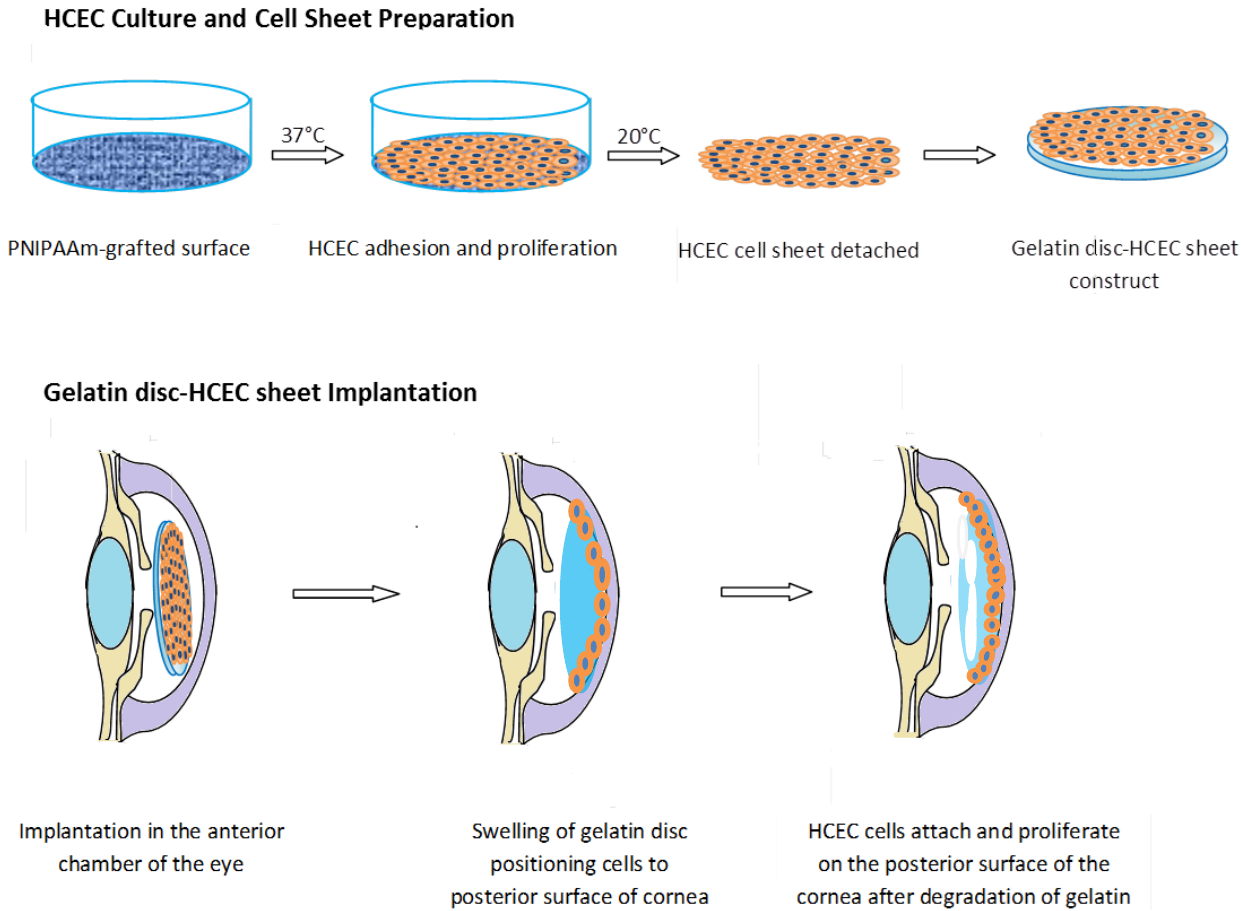
Figure 3. Schematic diagram of HCEC-gelatin sheet implantation reported by Lai et al. [73]. Primary endothelial cells were cultured upon a pNIPAM culture surface until confluent. The cell sheet was detached and transferred to a gelatin disc. The gelatin disc was implanted into the anterior chamber of the rabbit eye in which the endothelium had been removed surgically. The gelatin disc swelled localizing the corneal endothelial cells against the posterior surface of the cornea, where the cells proliferated and restored the cornea to health. Figure adapted from Hsiue et al.